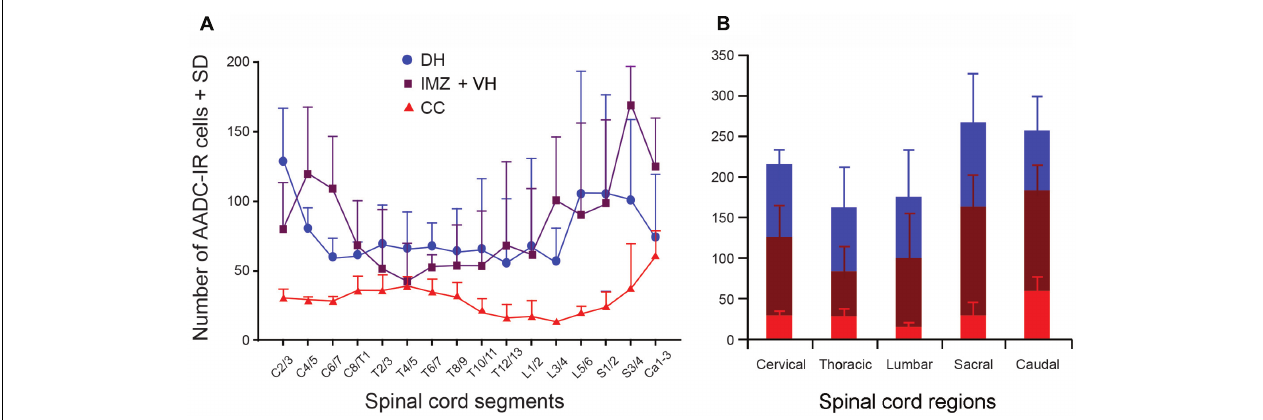
FIGURE 10 | Histograms showing the density of the AADC cells in different spinal segments. (A) AADC cell (neuron) distribution in the spinal gray matter. The density of AADC cells (number/mm 3 spinal tissue) in three different locations – the DH, IMZ plus ventral horn (IMZ + VH), and around the CC – were plotted in relation to the spinal segments. For the AADC cells in the DH the rostral cervical segments (C2/3) contained the highest density of the cells, and the caudal thoracic segments (T12/13) contained the lowest density of the cells. For the AADC cells in the IMZ + VH the caudal sacral segments (S3/4) contained the highest density, and the rostral thoracic segments (T4/5) contained the lowest density of the cells. For the AADC cells around the CC the highest densities were found in the caudal spinal cord and the lowest densities in mid-lumbar segments (L3/4). (B) Summarized data from (A) illustrating the AADC cell distribution in five spinal